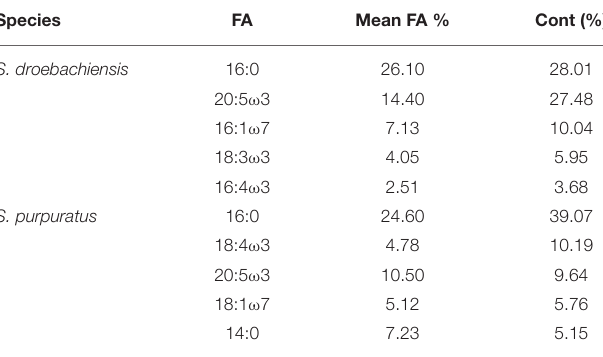
TABLE 3 | SIMPER results for analysis of combined FA of tissues from S. droebachiensis ( N = 12) and S. purpuratus ( N = 18). Species FA Mean FA % Cont (%)